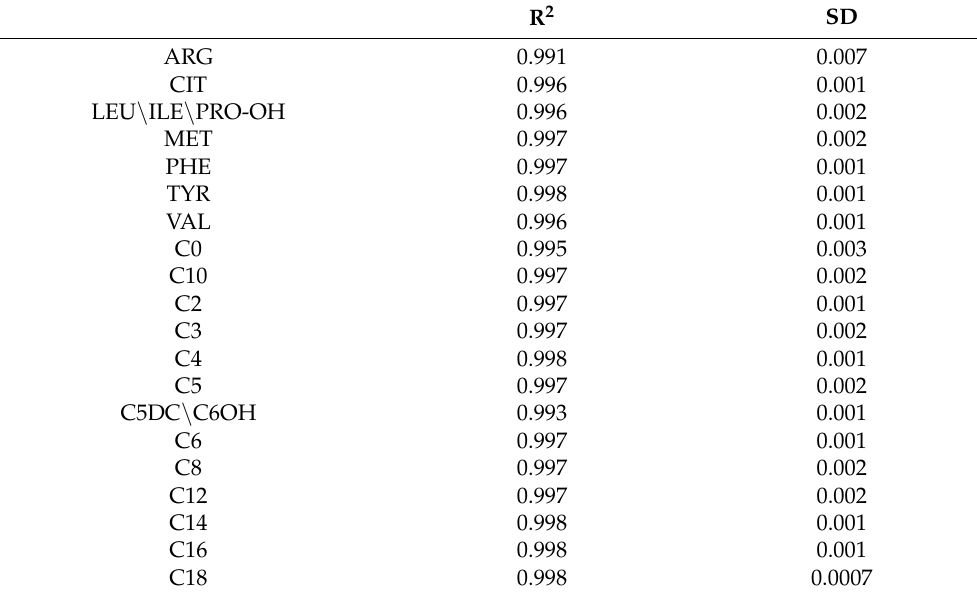
Table 2. R 2 and SD values from linearity validation by the analysis of 11 levels provided by MassChrom ® kit on the RenataDX Screening System (SD: standard deviation).